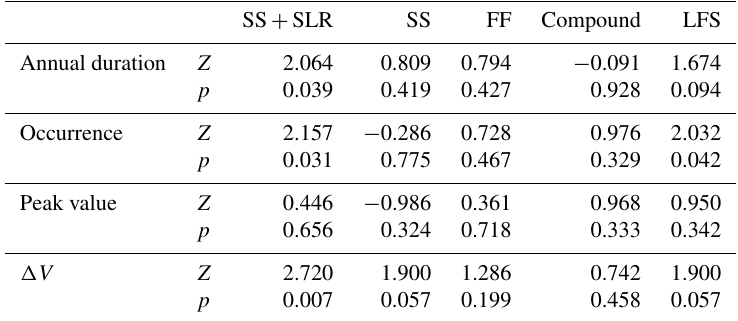
Table 1. The MK statistics of long-term trends in annual duration, occurrence, peak value and (cid:49)V